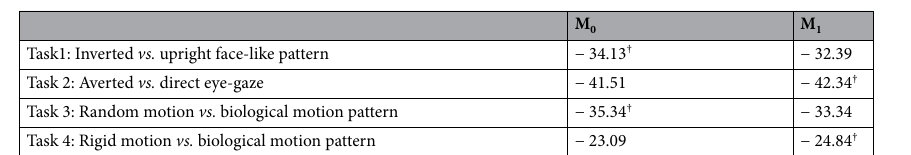
M 0 M 1 Task1: Inverted vs. upright face-like pattern − 34.13 † − 32.39 Task 2: Averted vs. direct eye-gaze − 41.51 − 42.34 † Task 3: Random motion vs. biological motion pattern − 35.34 † − 33.34 Task 4: Rigid motion vs. biological motion pattern − 23.09 − 24.84 Table 1. AIC indices for fixed-dispersion (M 0 ) and variable-dispersion (M 1 ) beta linear models adapted to each task separately. Note that models with lower AIC are marked with the symbol†.